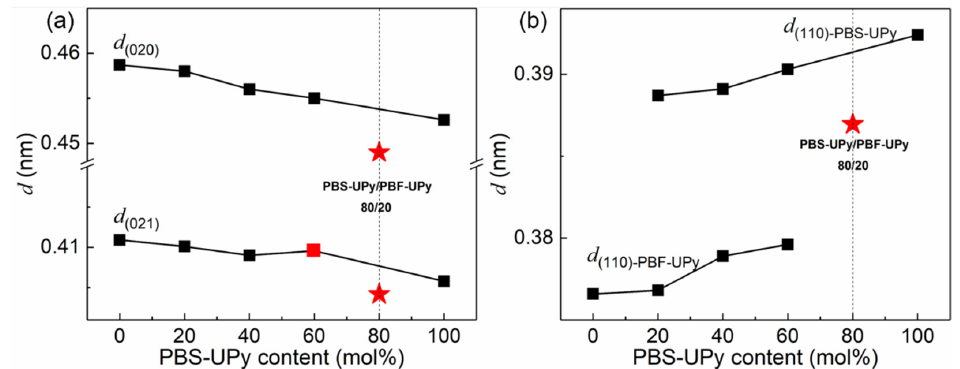
Figure 8. Dependences of (020), (021) interplanar spacings ( a ) and (110) interplanar spacings ( b ) on PBS ‐ UPy content in PBS ‐ UPy/PBF ‐ UPy blends.